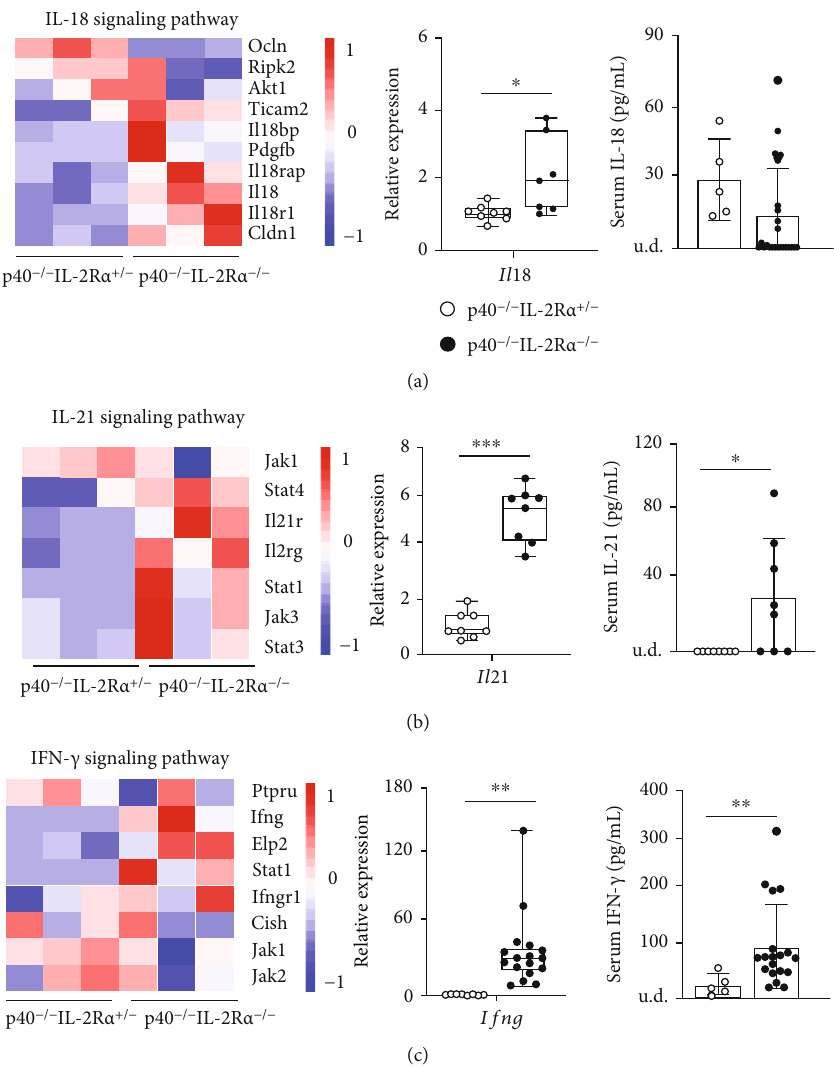
Figure 2: Expression of IL-18, IL-21, and IFN- γ was upregulated in p40 -/- IL-2Ra -/- mice. (a) Heat map showing genes contained in the IL-18 pathway; quantitative real-time PCR analysis for IL-18 mRNA levels in p40 -/- IL-2Ra -/- ( n = 7 ) and p40 -/- IL-2Ra +/- ( n = 8 ) mice and serum IL-18 levels in p40 -/- IL-2Ra -/- ( n = 25 ) and p40 -/- IL-2Ra +/- ( n = 5 ) mice. (b) Heat map showing genes involved in the IL-21 signaling pathway; quantitative real-time PCR analysis for IL-21 mRNA levels in p40 -/- IL-2Ra -/- ( n = 8 ) and p40 -/- IL-2Ra +/- ( n = 8 ) mice and serum IL-21 levels in p40 -/- IL-2Ra -/- ( n = 8 ) and p40 -/- IL-2Ra +/- ( n = 8 ) mice. (c) Heat map showing genes involved in the IFN- γ signaling pathway; quantitative real-time PCR analysis for IFN- γ mRNA levels in p40 -/- IL-2Ra -/- ( n = 17 ) and p40 -/- IL-2Ra +/- ( n = 8 ) mice and serum IFN- γ levels in p40 -/- IL-2Ra -/- ( n = 19 ) and p40 -/- IL-2Ra +/- ( n = 5 ) mice. ∗ p < 0 : 05, ∗∗ p < 0 : 01, and ∗∗∗ p < 0 : 001 . Abbreviations: u.d.: